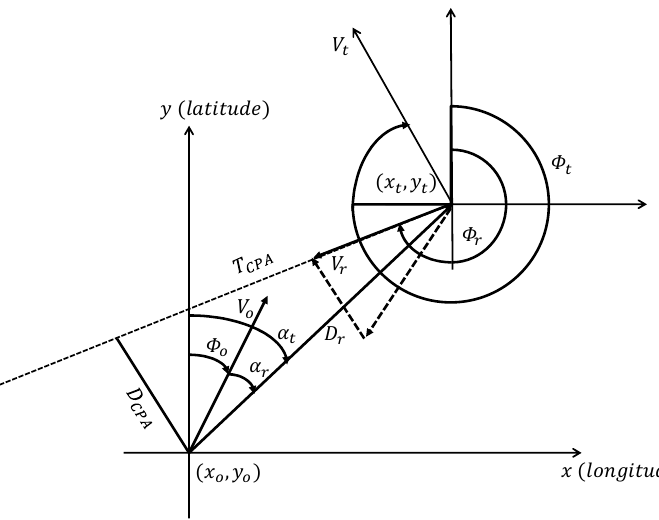
Figure 4. Illustration of the closest point of approach.